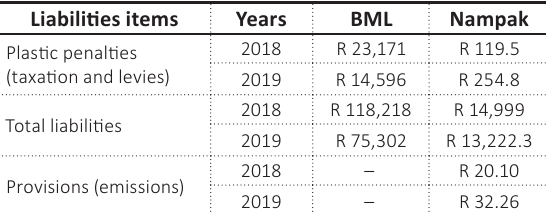
Table 2. Abstract of the two plastic